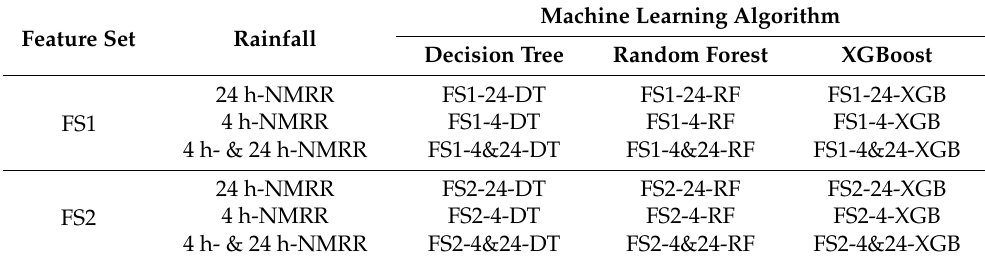
Table 6. Summary of Analysis Cases Considered in the Pilot